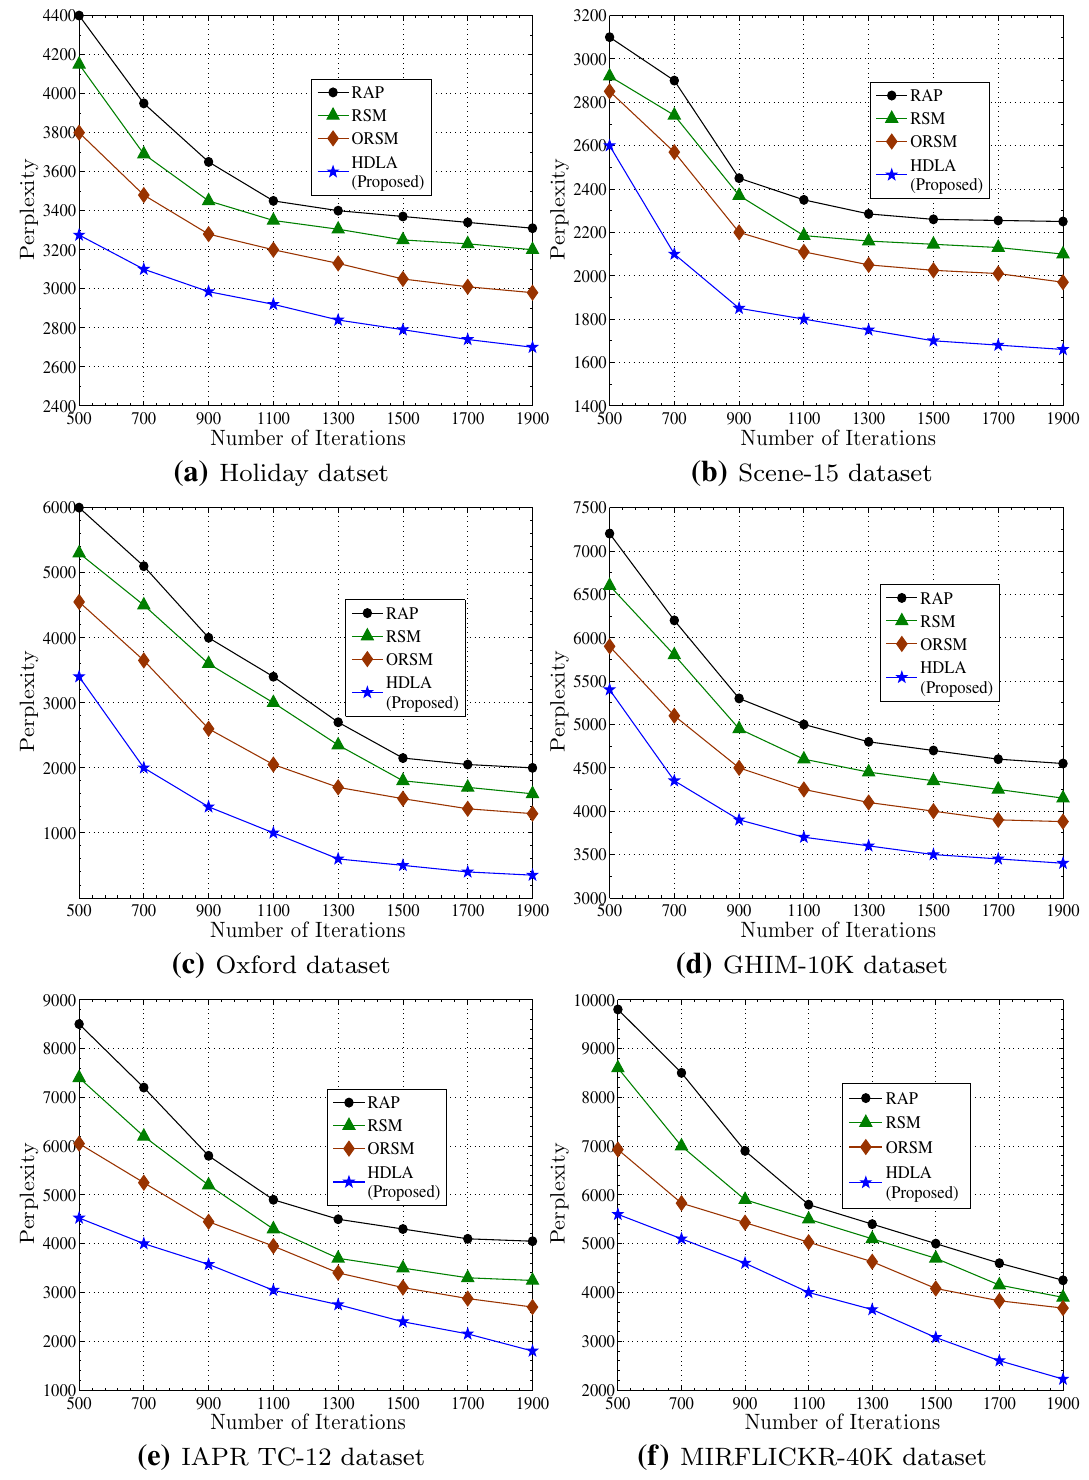
Fig. 8 Test perplexity values versus iteration count of the proposed HDLA model in comparison with state-of-the-art latent topic modeling approaches. a Holiday datset. b Scene-15 dataset. c Oxford dataset. d GHIM-10K dataset. e IAPR TC-12 dataset. f MIRFLICKR-40K